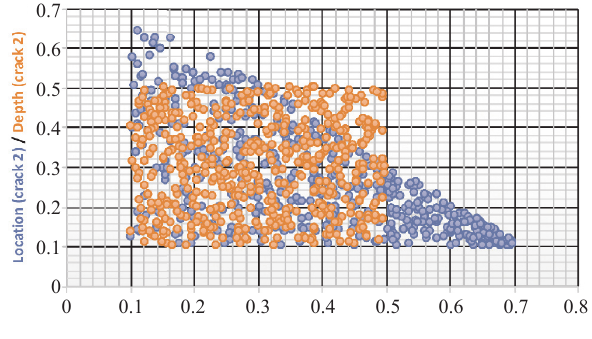
Fig. 2. Distributi Fig. 2. Distribution of the crack characteristics in the